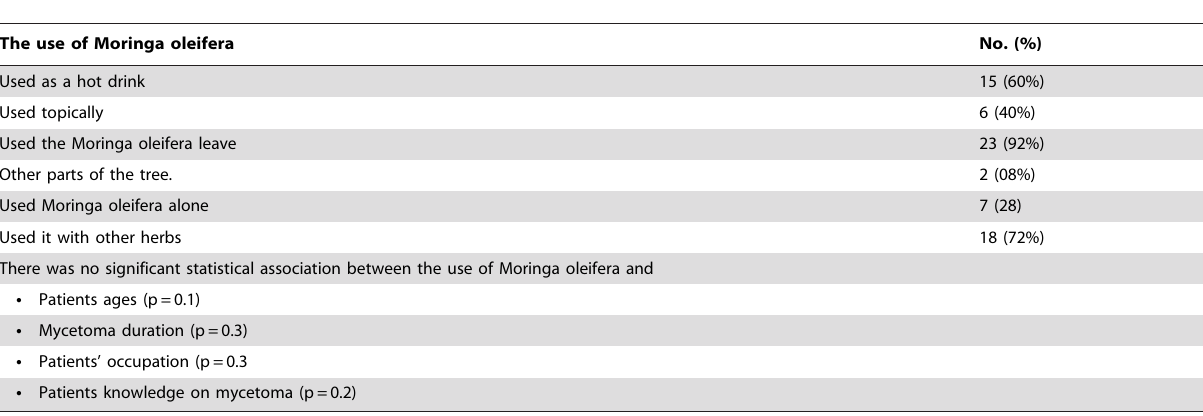
Table 4. The use of Moringa oleifera among the study population.